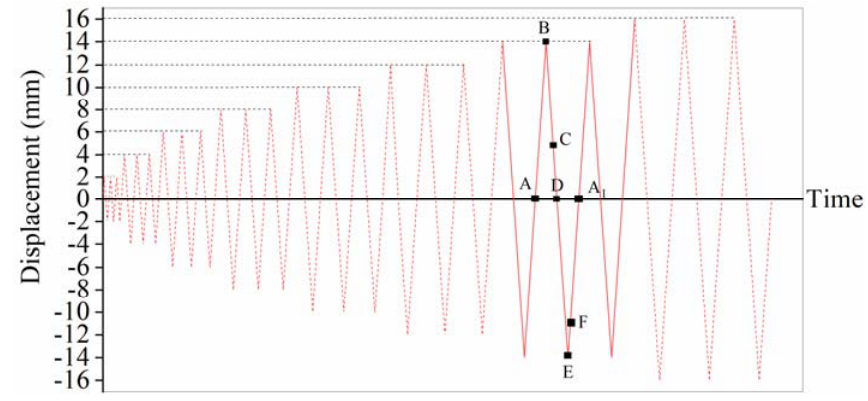
Figure 14. Illustration of ±14 mm displacement load.